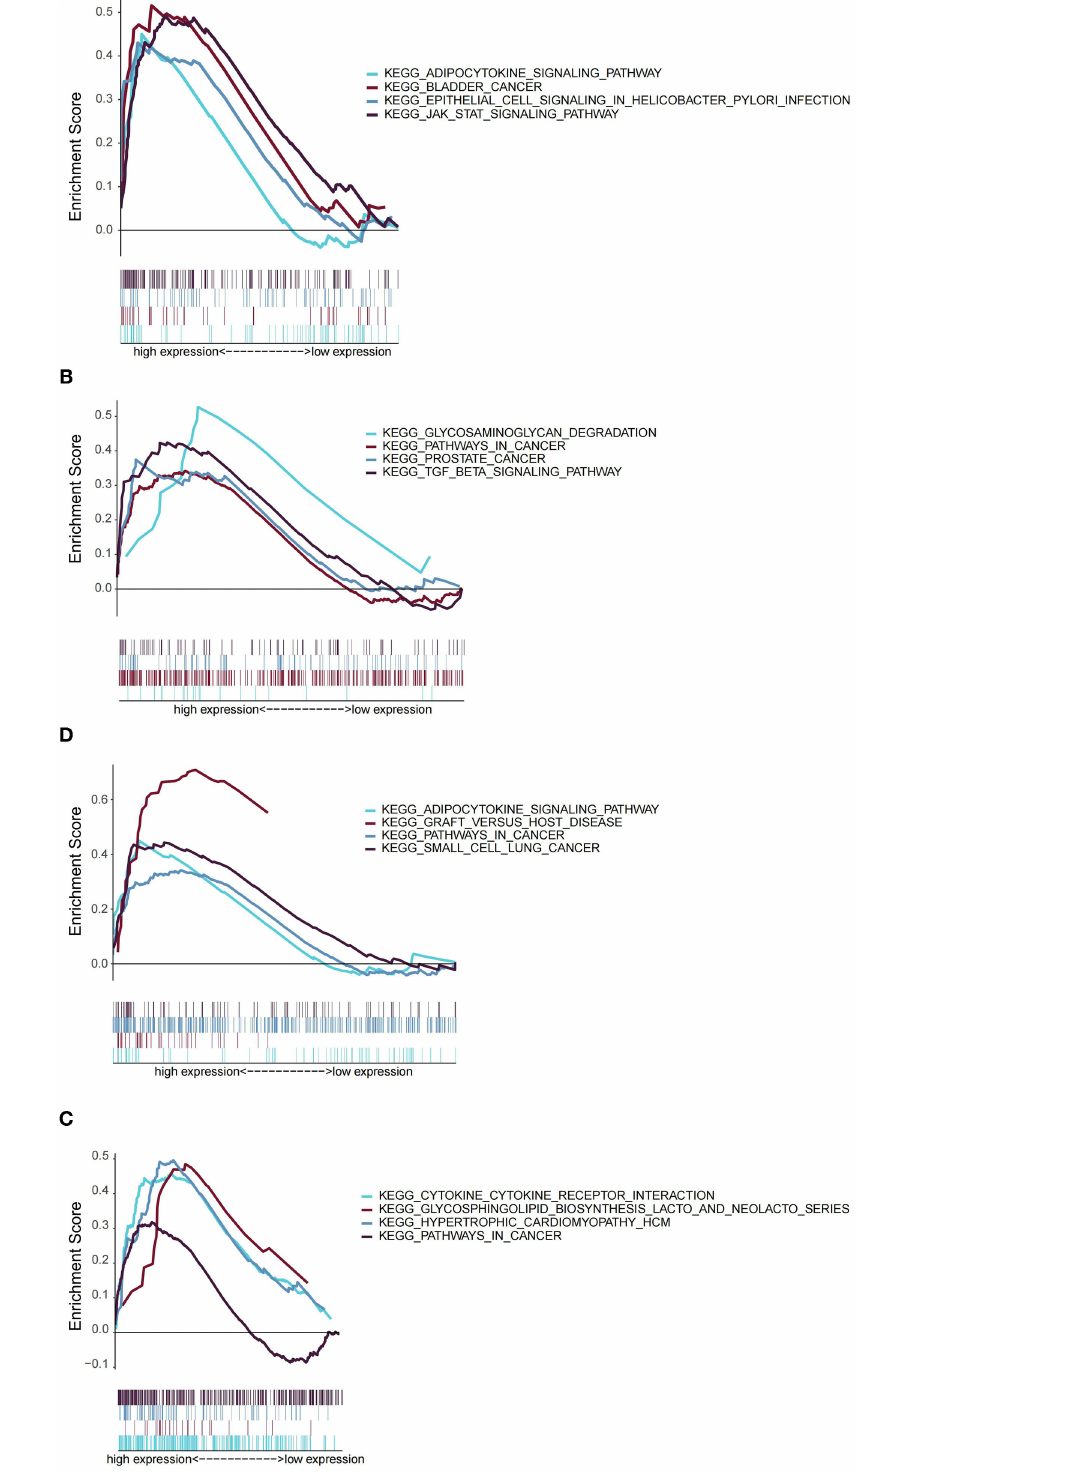
FIGURE 7 | GSEA analysis of functions related to AREG (A) , ATF3 (B) , DUSP1 (C) , and ZFP36 (D) .